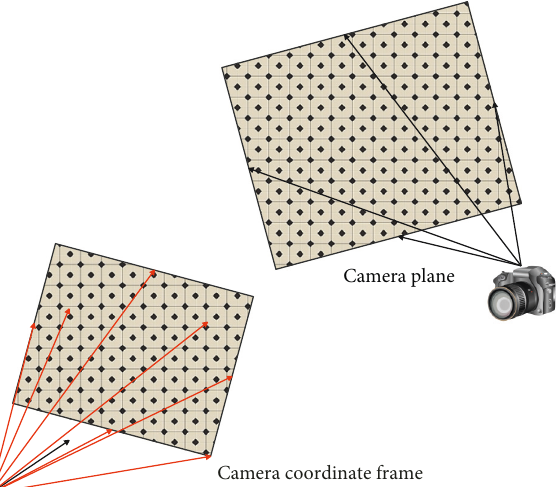
Figure 4: Calibration plate plane.